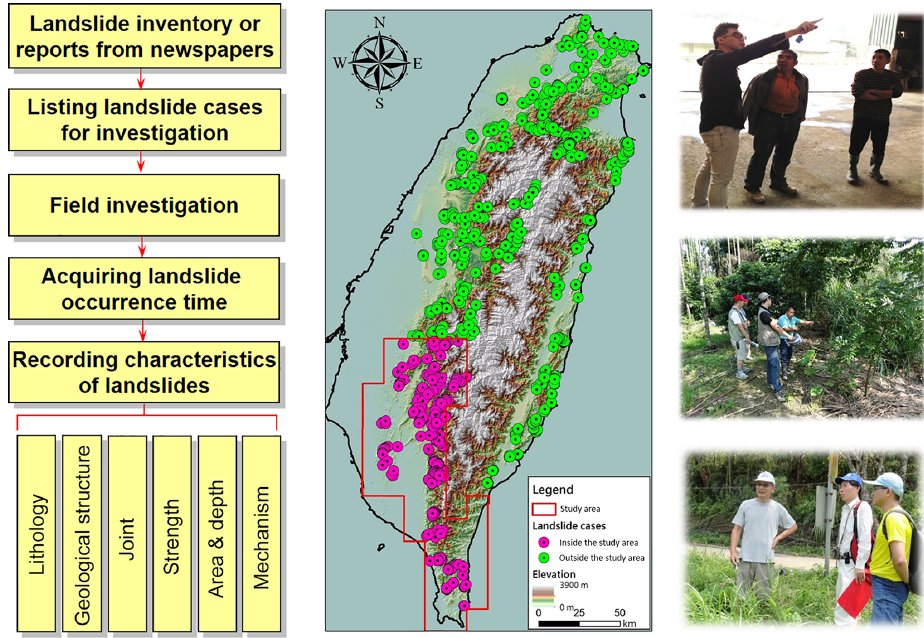
Figure 2. Flowchart of landslide occurrence time gathering during field investigation (left), locations of landslide cases with the occurrence times used in this study (middle) and the pictures of interviewing residents (right). To improve the quality of this key information, landslide occurrence times were obtained from local residents, especially those whose relatives were injured or houses were damaged or destroyed by the landslides.